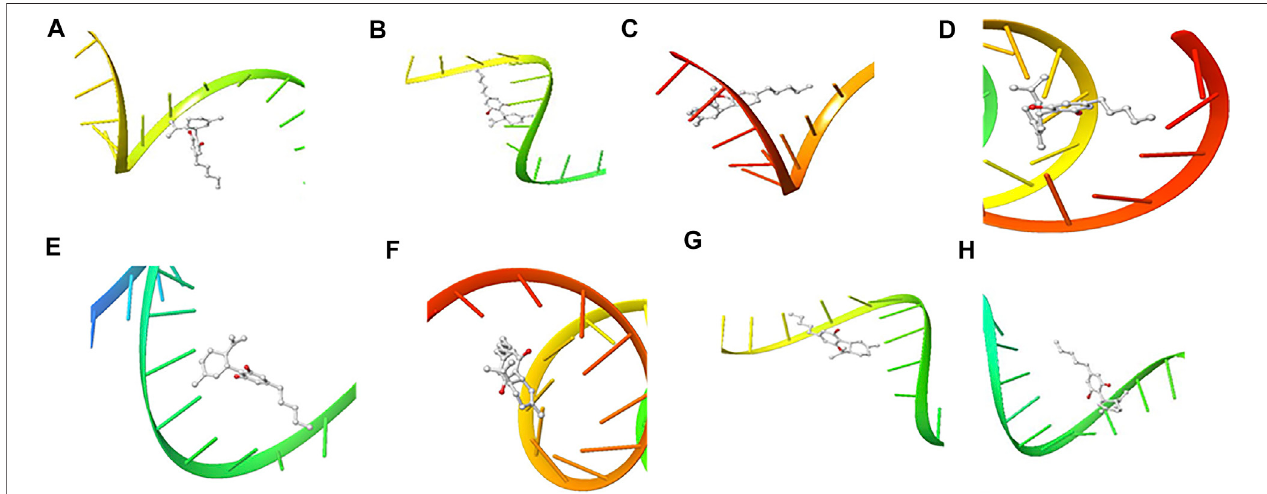
FIGURE 8 | 3D Interaction of Cannabidiol with Initiation and Termination Sequence of the Viral Proteins. A (cid:1) Nucleocapsid Phosphoprotein Translation Initiation Site;B (cid:1) EnvelopeProteinTranslationInitiationSite;C (cid:1) EnvelopeProteinTranslationTerminationSite;D (cid:1) NucleocapsidPhosphoproteinTranslationTerminationSite;